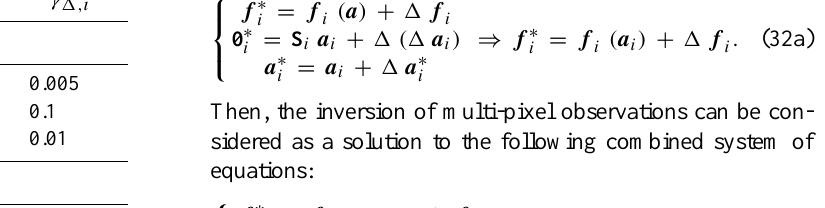
Table 3. The finite differences used for smoothness constrains and the correspondent values of Lagrange multipliers γ 1,i . Order of finite Values of